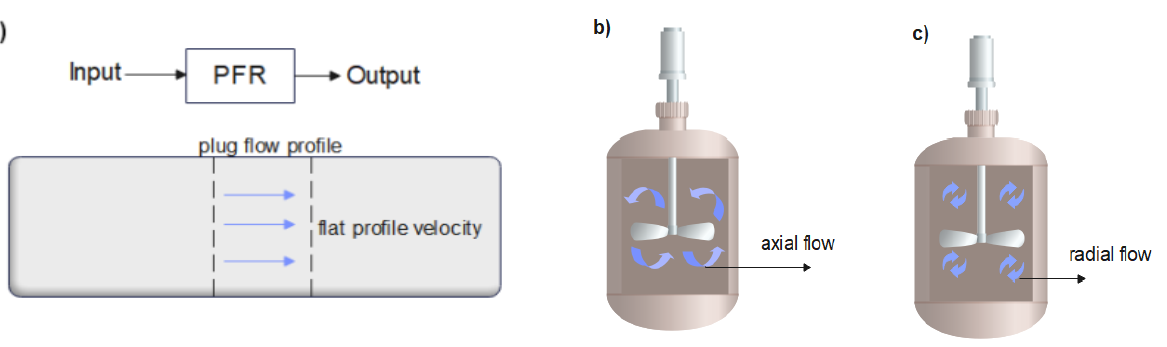
Figure 8. Fluid flow patterns: ( a ) plug flow (this figure is an adaptation of a figure contained in [150]); ( b ) axial flow; and ( c ) radial flow in reactors figures ( b ) and ( c ) are adapted from a figure contained in [149]).